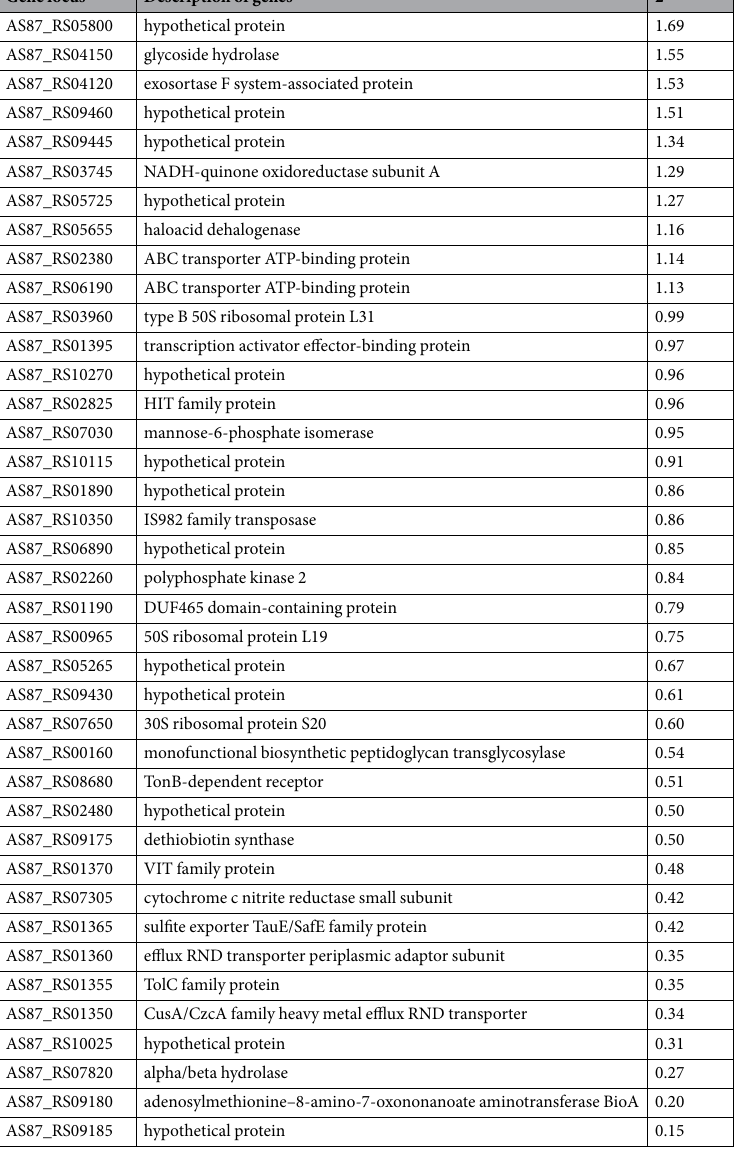
Table 1. Real-time PCR verification of differentially expressed genes in mutant strain Yb2 Δ bioF. a Based on indicated that the gene is expressed similarly in both mutant strain Yb2 Δ bioF and wild-type strain Yb2, figures > 1 indicated that the gene is over expressed in mutant strain Yb2 Δ bioF, and figures < 1 indicated that the gene is expressed less in mutant strain Yb2 Δ